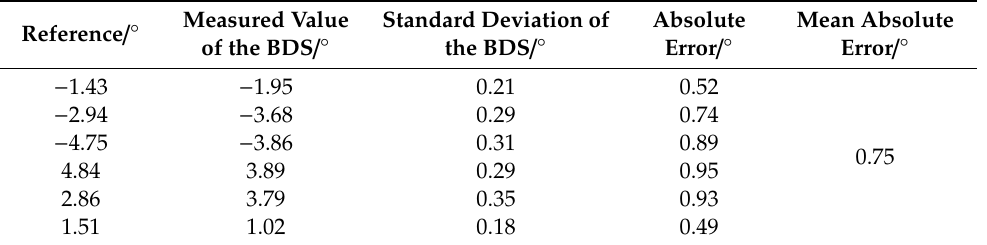
Table 2. Measurement of roll angle from the